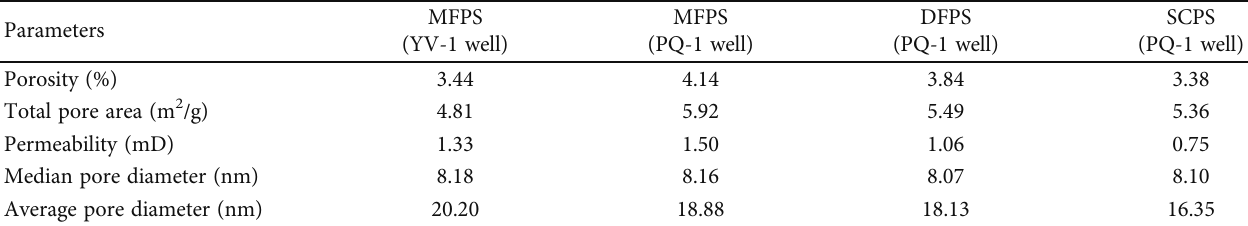
Table 1: Average porosity, surface area, permeability, median pore diameter, and average pore diameter of various coal facies based on mercury intrusion porosimetry experiment